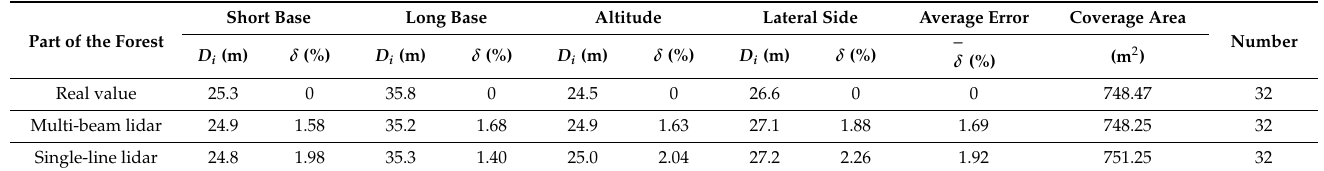
Table 4. Measurement data of some forest